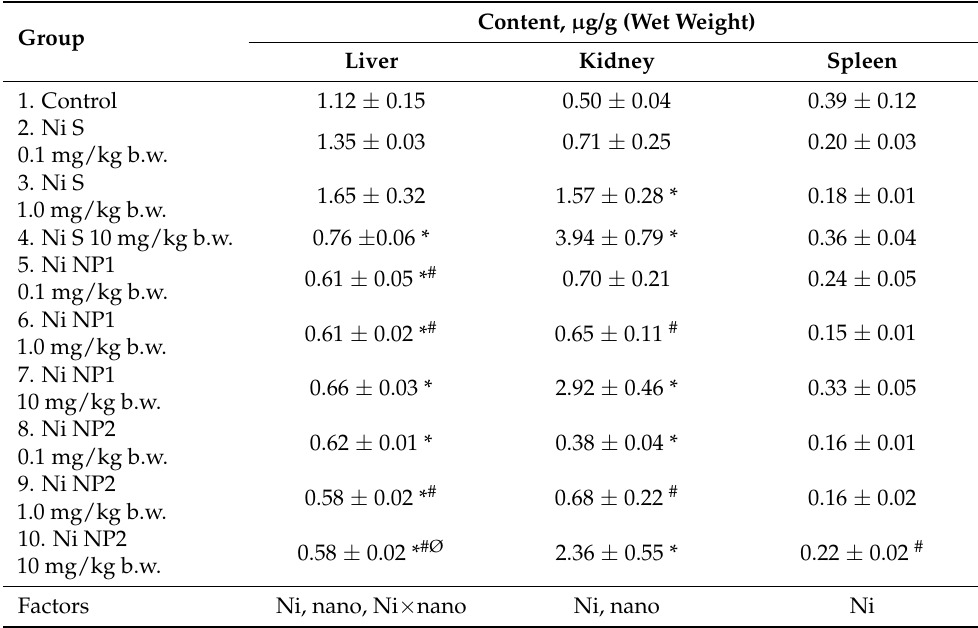
Table 4. Mean (M ± S.E.M.) Ni content in the organs of rats at withdrawal from the experiment.